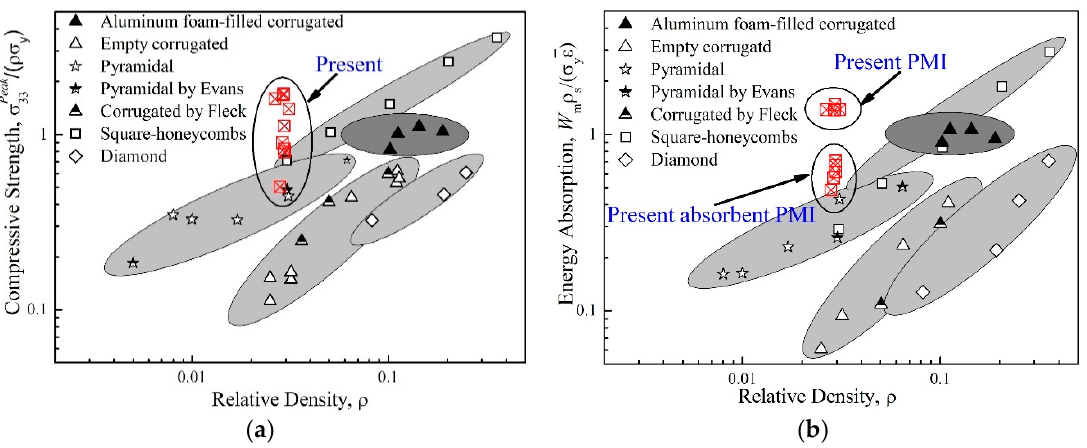
Figure 9. Comparison of present tube-enhanced normal and absorbent PMI foams with competing sandwich core designs [36]. ( a ) Specific compressive strength and ( b ) Specific energy absorption.